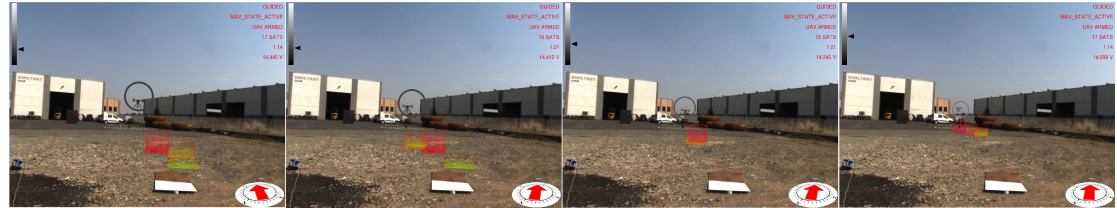
Figure 13. Example images of the augmented reality environment in an industrial setting.